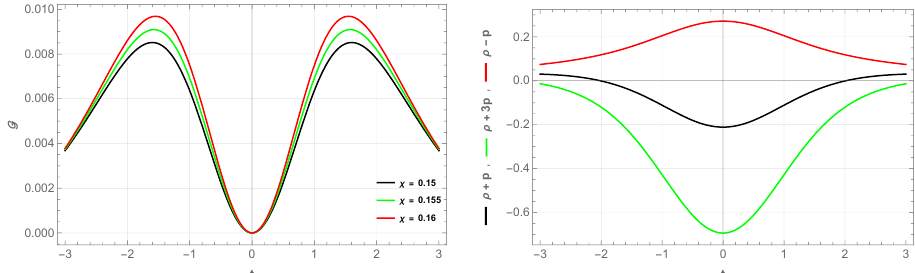
Figure 3. Behavior of Gauss–Bonnet invariant ( left panel ) and energy conditions ( right panel ) versus cosmic time t . The parameters values are α = − 0.30, β =